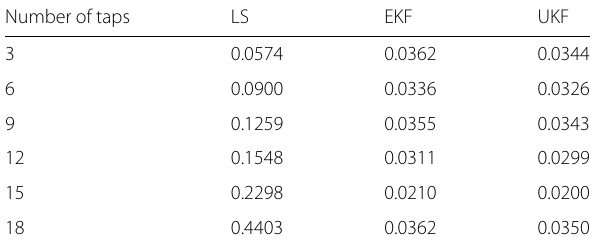
Table 3 The mean for BEM-based channel estimation methods in different taps